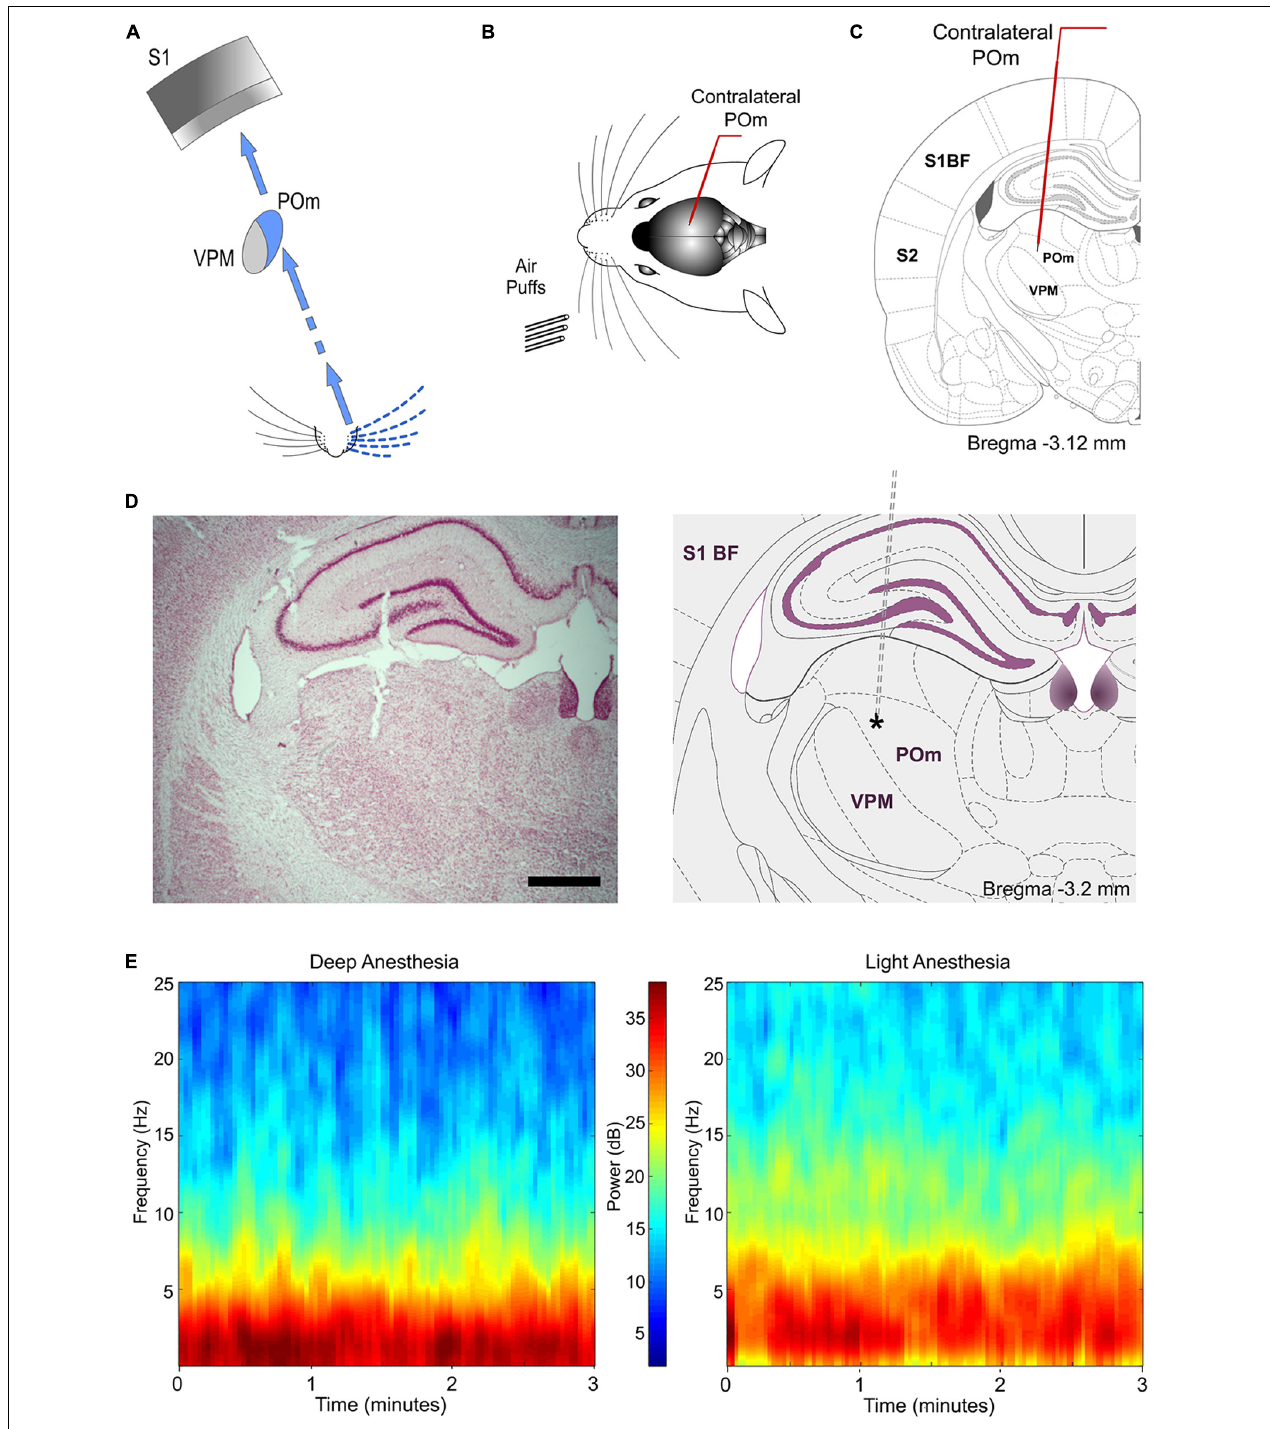
FIGURE 1 | Experimental paradigm. (A) Illustration of the paralemniscal pathway. (B) Schematic drawing displaying the sensory stimulation via patterns of multiwhisker deflections. Recordings were made in the contralateral POm (C) . Coronal section illustrating a recording electrode inserted into POm. Bregma anteroposterior level is indicated. (D) The left panel shows a representative Nissl stained coronal section displaying the location of the recording site in the dorsolateral part of POm and the track left by the electrode. An atlas schematic reconstruction of this recording site within POm is shown in the right panel (Paxinos and Watson, 2007). Tip position is indicated by an asterisk. Scale bar, 1 mm. S1 BF, primary somatosensory cortex barrel field. S2, secondary somatosensory cortex. (E) POm LFP spectrograms of both deeply and lightly anesthetized states. Power spectra dominated by 1–2 Hz were only observed during deep anesthesia (Friedberg et al., 1999). Our recordings were mostly performed in the lightly anesthetized state.